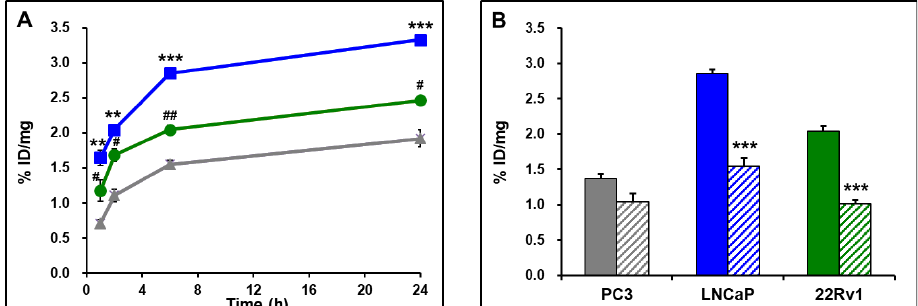
Figure 3. ( A ) Binding of [ 64 Cu] 3B to prostate cancer cells (PC3 ( ), 22Rv1 ( ○ ), and LNCaP ( □ )) at 37 °C for 1, 2, 6, and 24 h. Data are expressed as mean ± SEM. ** p < 0.01 and *** p < 0.001 vs. PC3. # P < 0.05 and ## p < 0.01 vs. PC3. ( B ) Blocking of the cell binding in the presence of 3B (20 μM) at 37 °C for 6 h. Control: PC3 (grey), LNCaP (blue), and 22Rv1 (green) cells; block: PC3 (grey stripe), LNCaP (blue stripe), and 22Rv1 (green stripe). *** p < 0.001 vs. control.